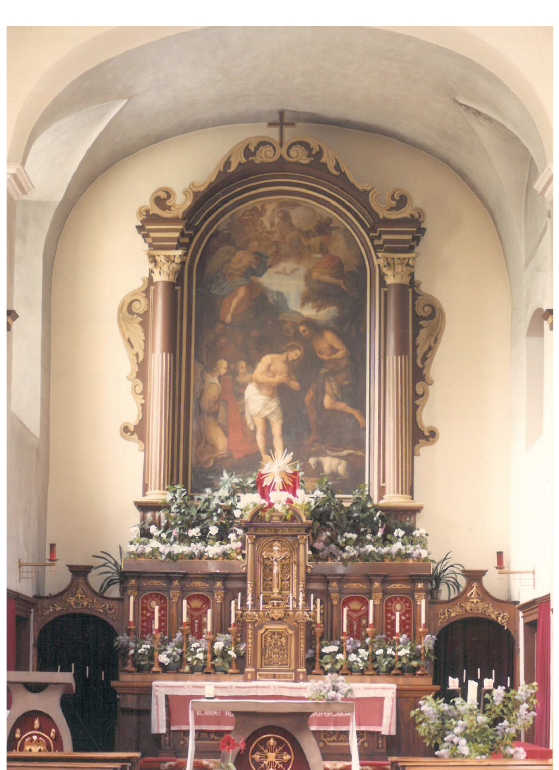
Figure 5: The present situation of the altar ensemble